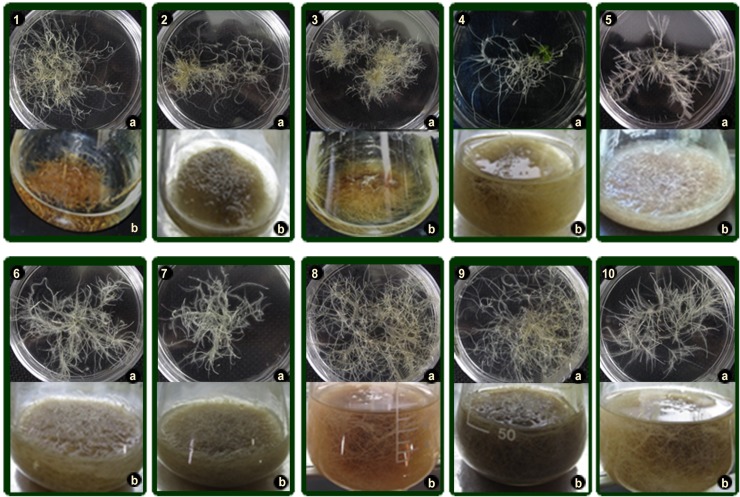
Ten selected HR lines.Individualized in solid MSB5 culture medium (1a – 10a) and in liquid MSB5
liquid culture medium (1b – 10b) without hormones.